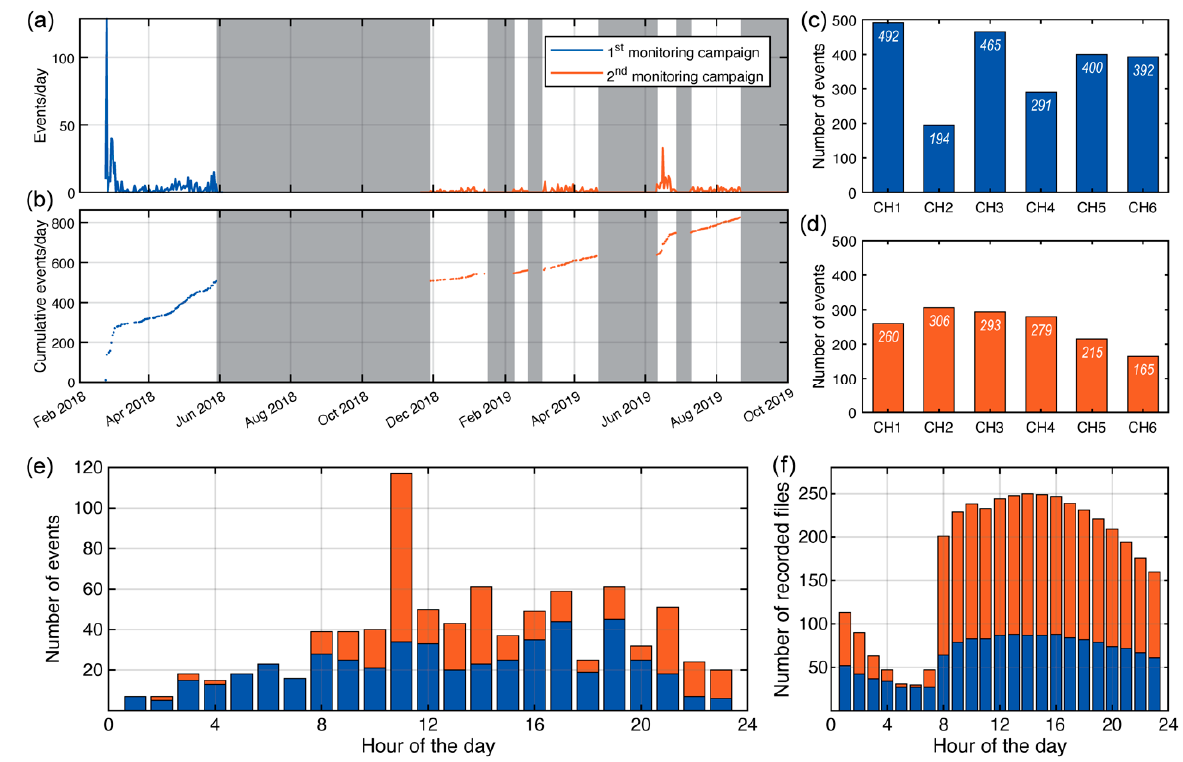
Figure 5. MS dataset collected at the Acuto field laboratory during the two monitoring campaigns conducted between February 2018 and October 2019. Number of events per day ( a ), cumulative number of events ( b ), and number of events detected per accelerometers during the first ( c ) and second monitoring campaign ( d ). Distributions of the detected events ( e ) and of the 1 h recorded files ( f ) during both monitoring campaigns as a function of the hour of the day.